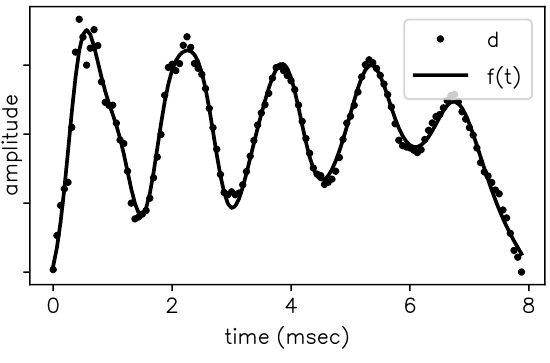
Figure 2. One pitch period extracted from a SSV / E / plotted as samples (the dots) together with the model function fit f ( t ; P , Q , ˆ A k , ˆ B j , ˆ C j , ˆ Ω ) (smooth